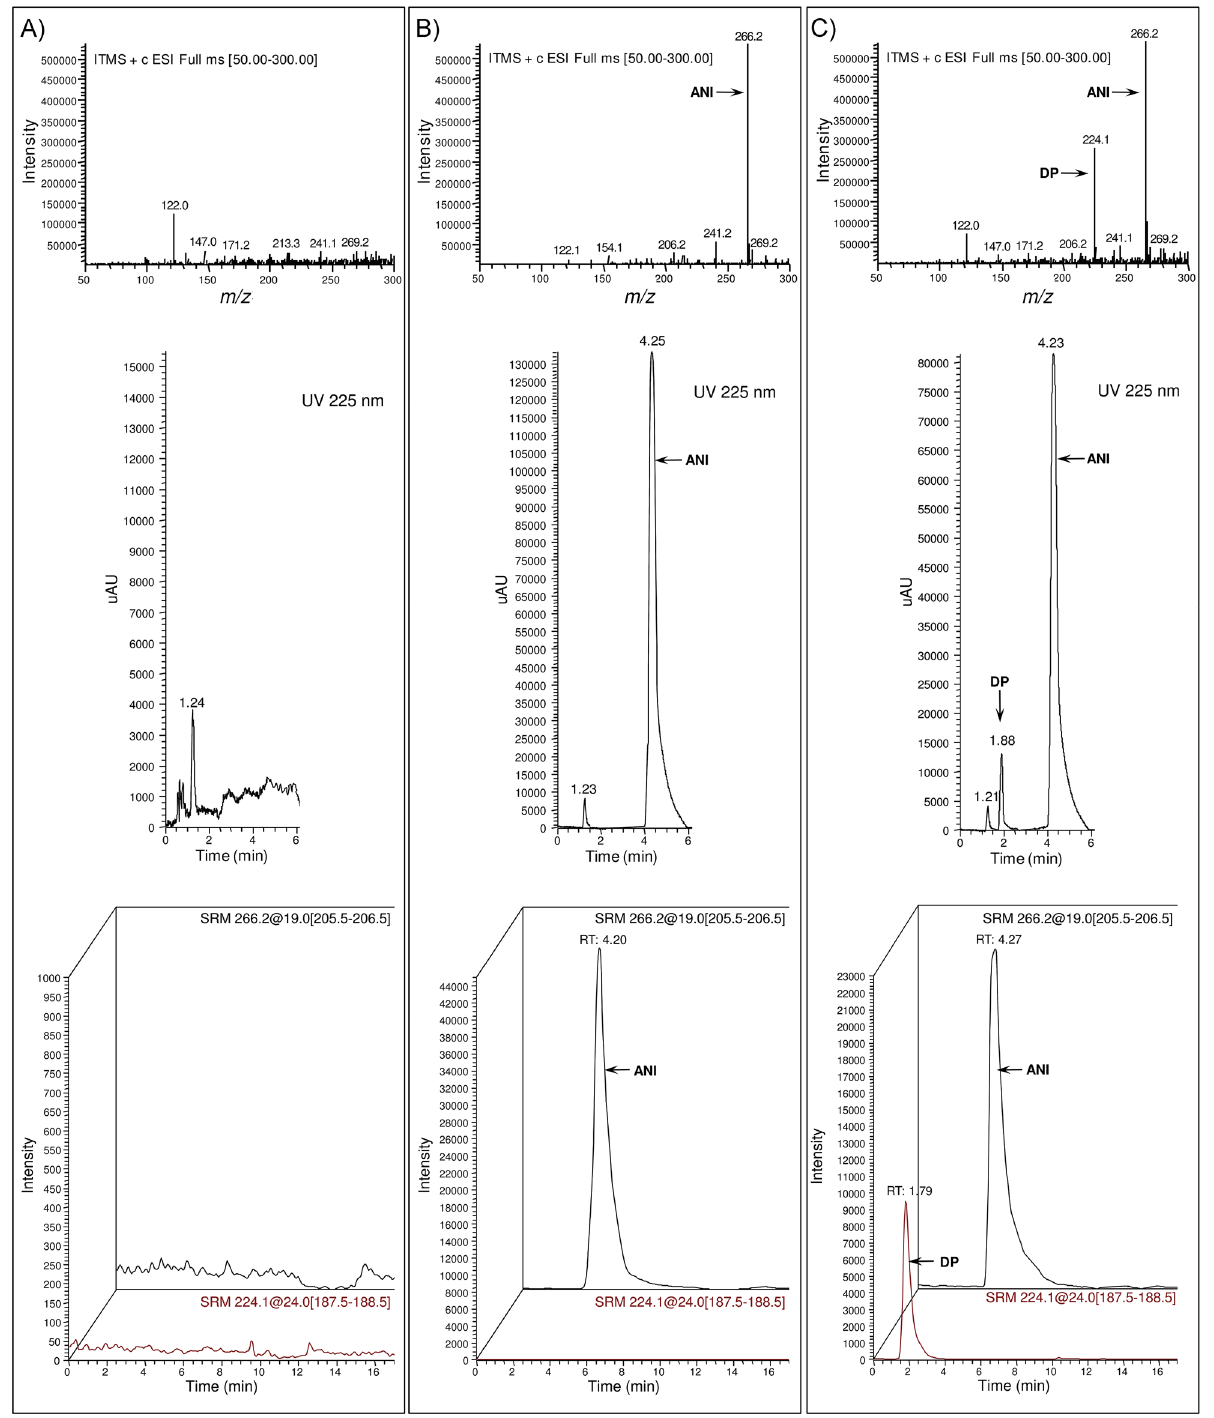
FIGURE 2 - Mass spectra, LC–UV and LC–MS/MS chromatograms of: A) blank sample, B) standard solution of anisomycin (ANI), C) stressed sample (neutral hydrolysis) with degradation product